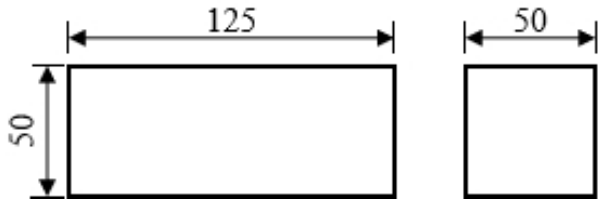
Figure 2. Upsetting sample geometry (lengths in mm).